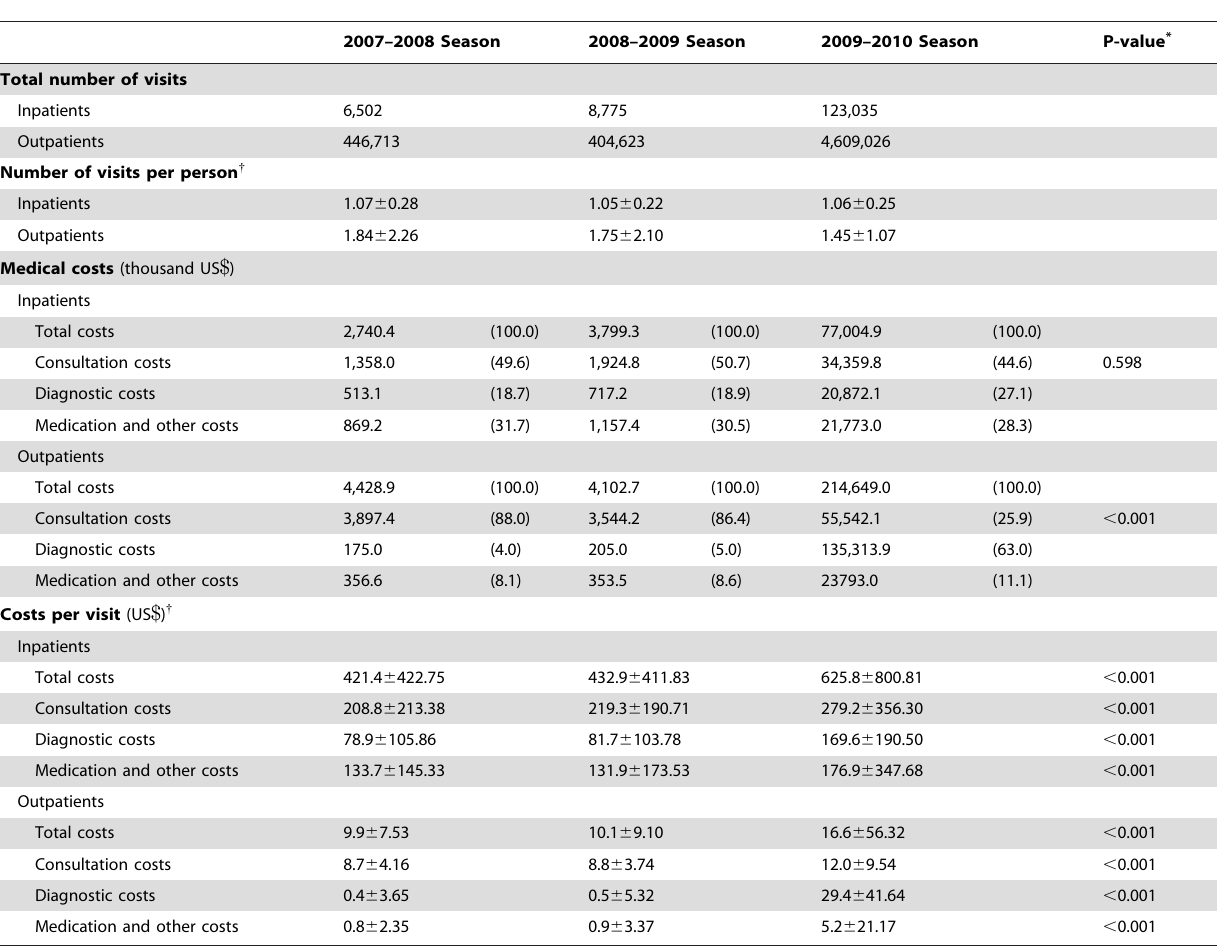
Table 2. Number of Visits and Medical Costs for Influenza in the Republic of Korea,